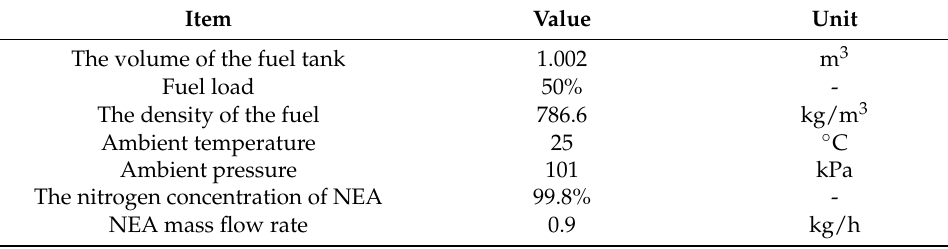
Table 1. The ground-based experimental condition used in